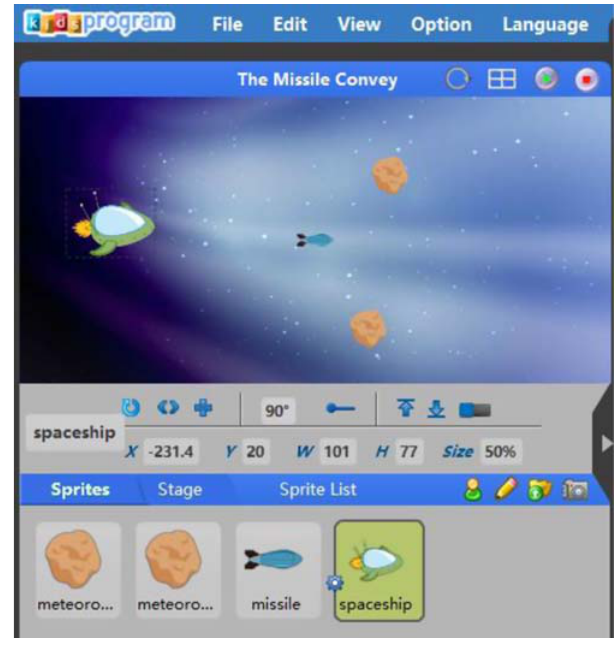
Figure 3. The example of student ’ s interface design